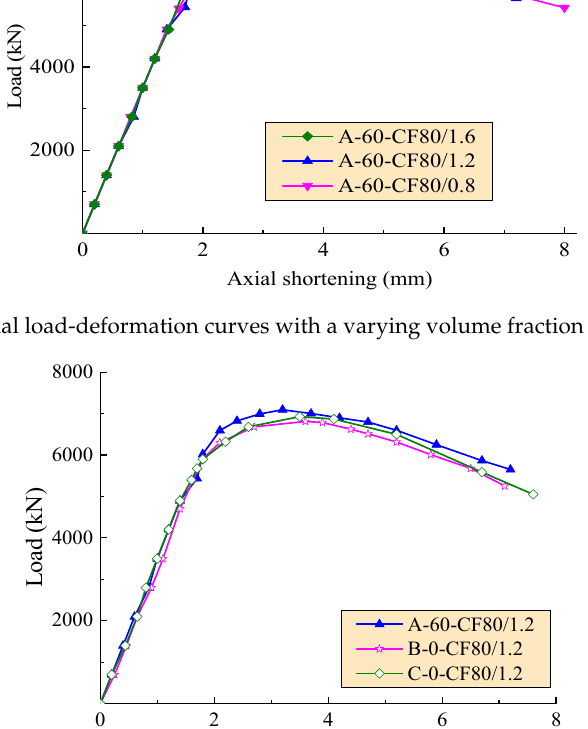
Table 3. Main test results of 10 specimens.